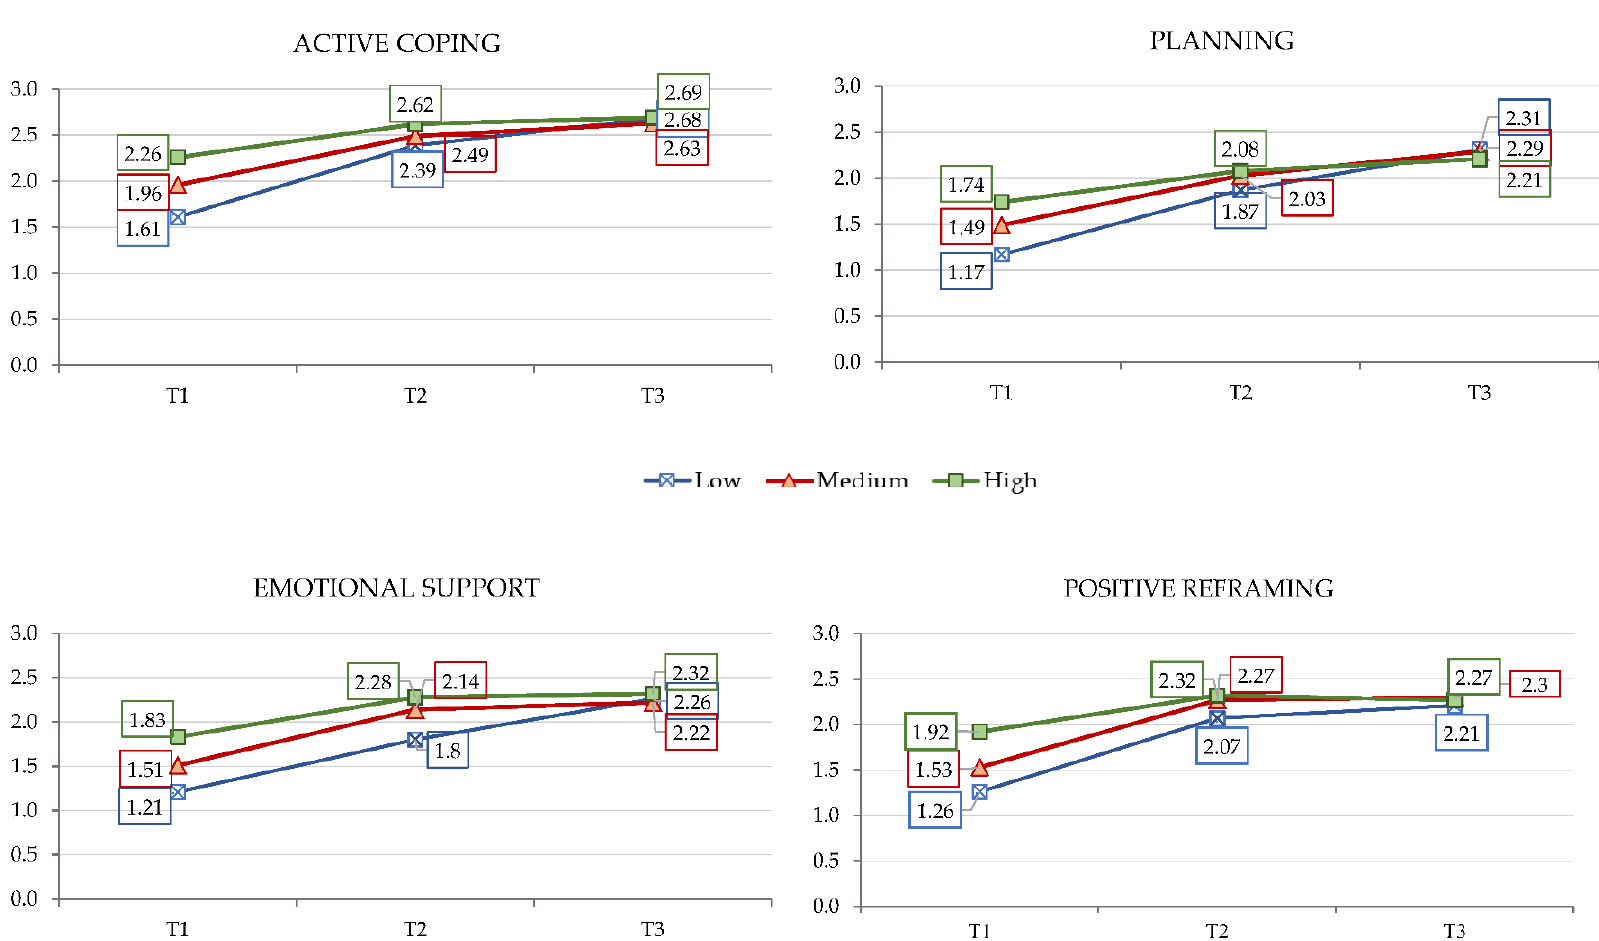
Figure 2. Interaction effects between initial level of post-traumatic growth and evaluation phases.